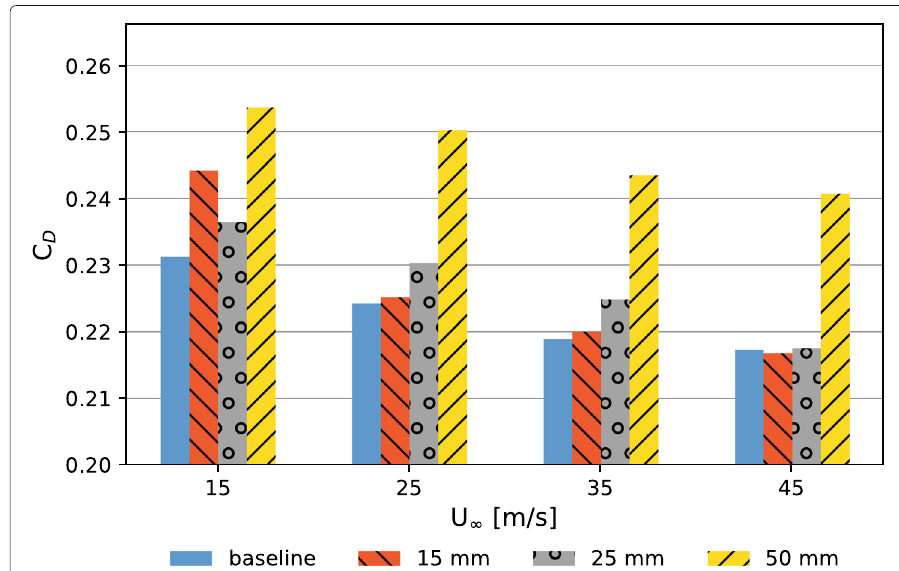
Fig. 9 Time-averaged drag coefficient for the notchback DrivAer model with conventional wheel